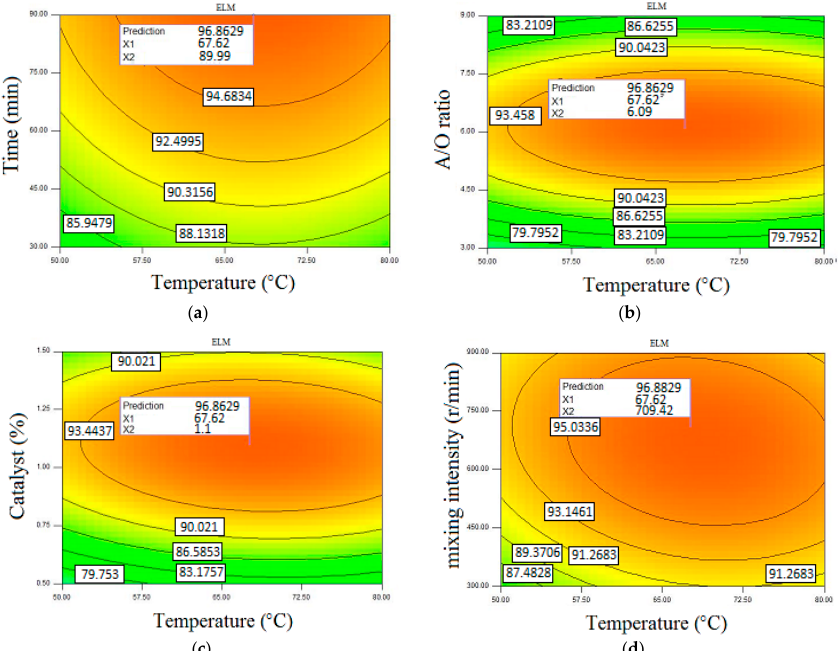
Figure 7. The optimization condition of methyl ester production in the case of using the RSM-ELM method. ( a ) Response surface based on time (min) and temperature (°C); ( b ) response surface based on A/O and temperature (°C); ( c ) response surface based on catalyst (wt. %) ratio and temperature (°C); and ( d ) response surface based on mixing intensity (r/min) and temperature (°C).